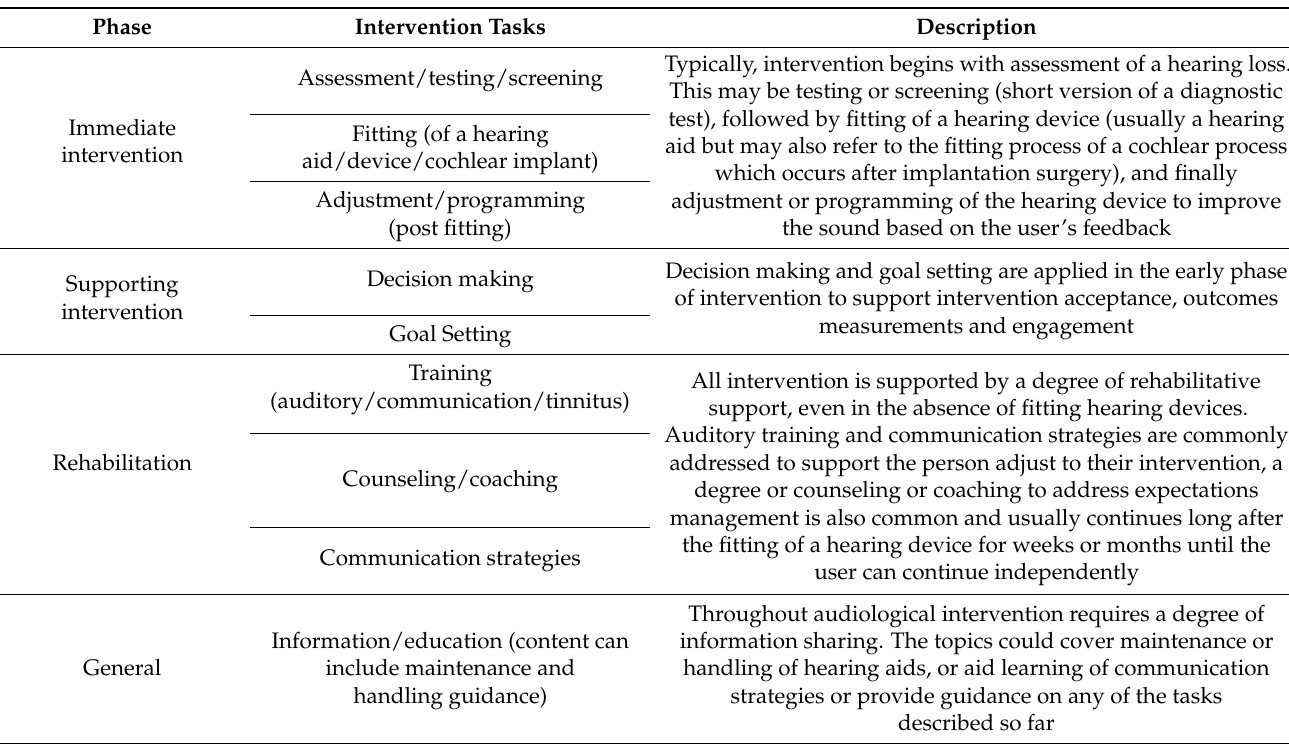
Table 2. Phase and intervention task